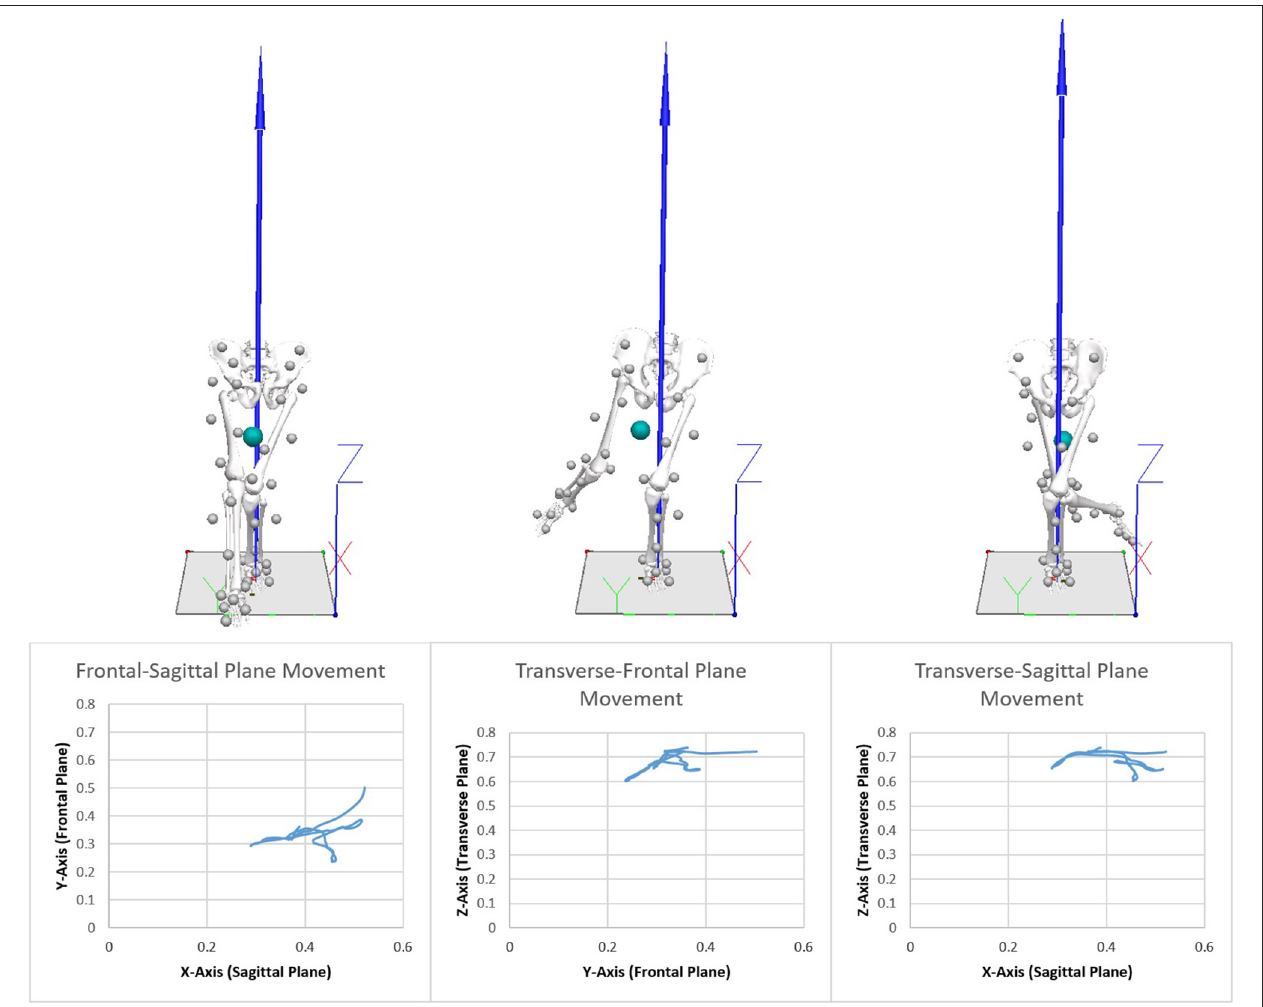
FIGURE 2 | An illustrative example of a Vicon 3D